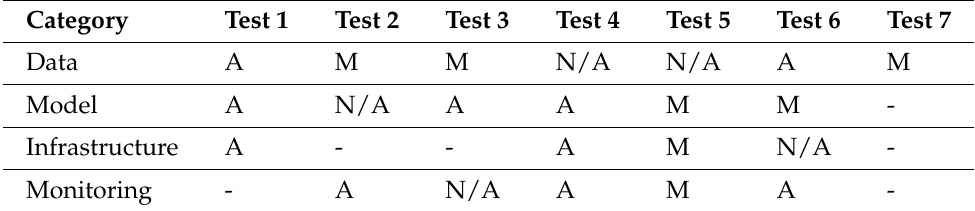
Table 4. Tests related to